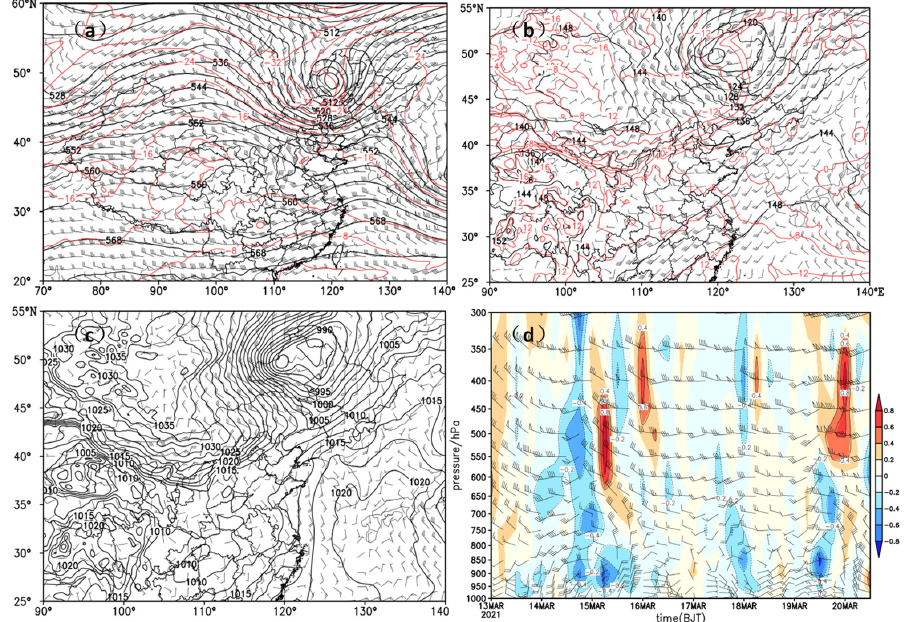
Figure 2. Weather situation map ( a ) 500 hPa, ( b ) 850 hPa, ( c ) surface at 08:00 on 15 March and ( d ) time evolution of three-dimensional wind (color, unit Pa·s − 1 ).